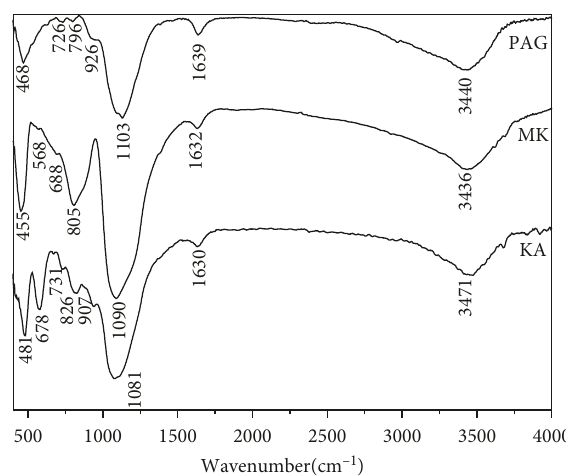
Figure 10: Loss of compressive strength of the solidified SPT samples with different TBP/OK contents.